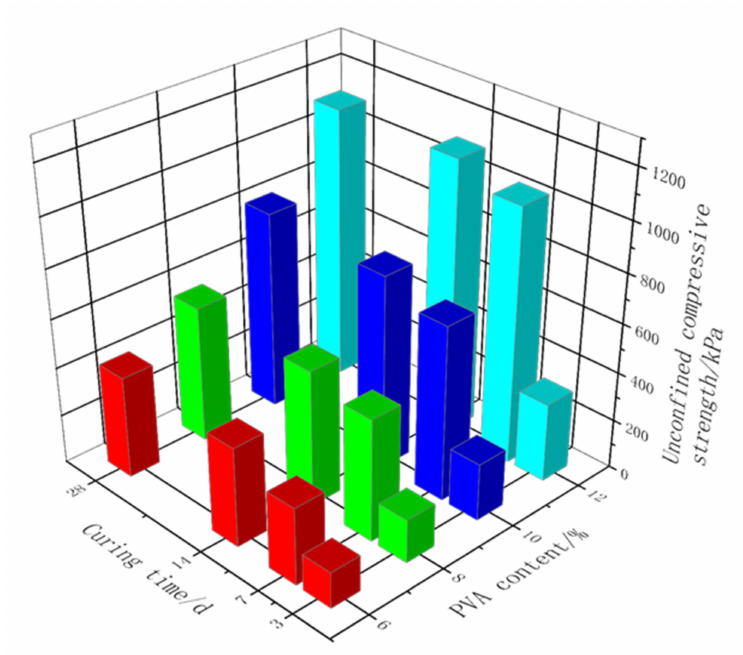
Figure 4. Statistical histogram of UCS of coarse-grained soil samples stabilized by PVA solution under different curing